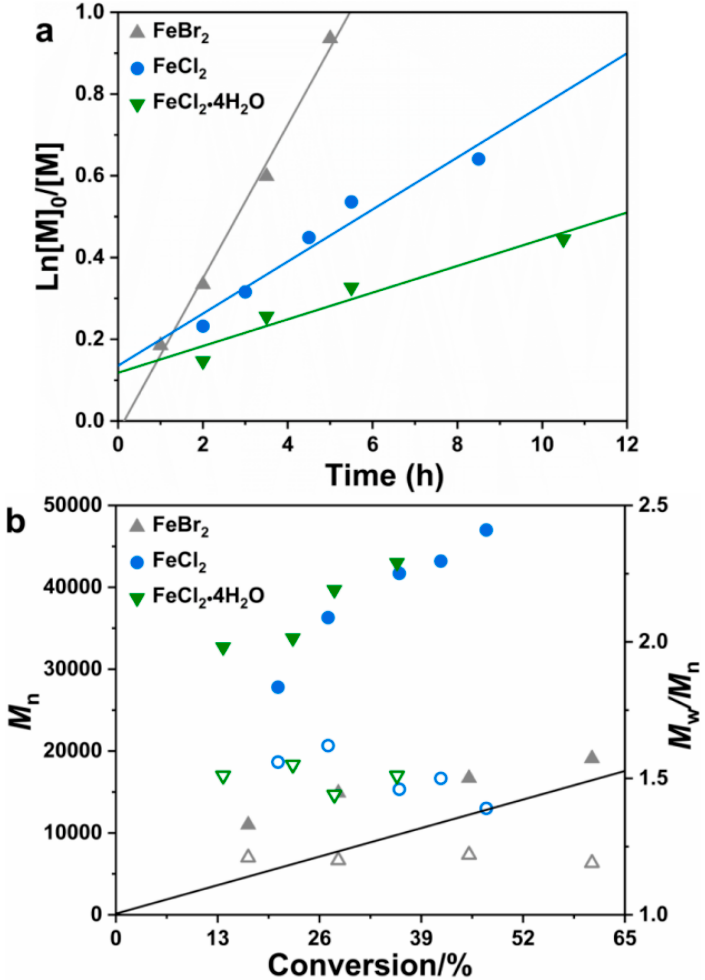
Figure 3. First-order plots ( a ) and evolution of M n and Đ with conversion ( b ) for the bulk iron-catalyzed MMA polymerization in the presence of di ff erent iron catalyst. [MMA]:[x]:[PEO 2000 -Br] =